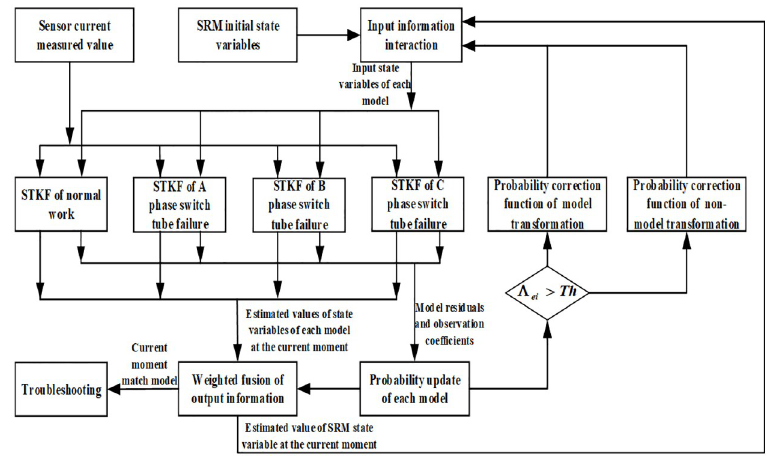
Fig 6. Flow chart of multi-fault diagnosis of SRM power converter based on